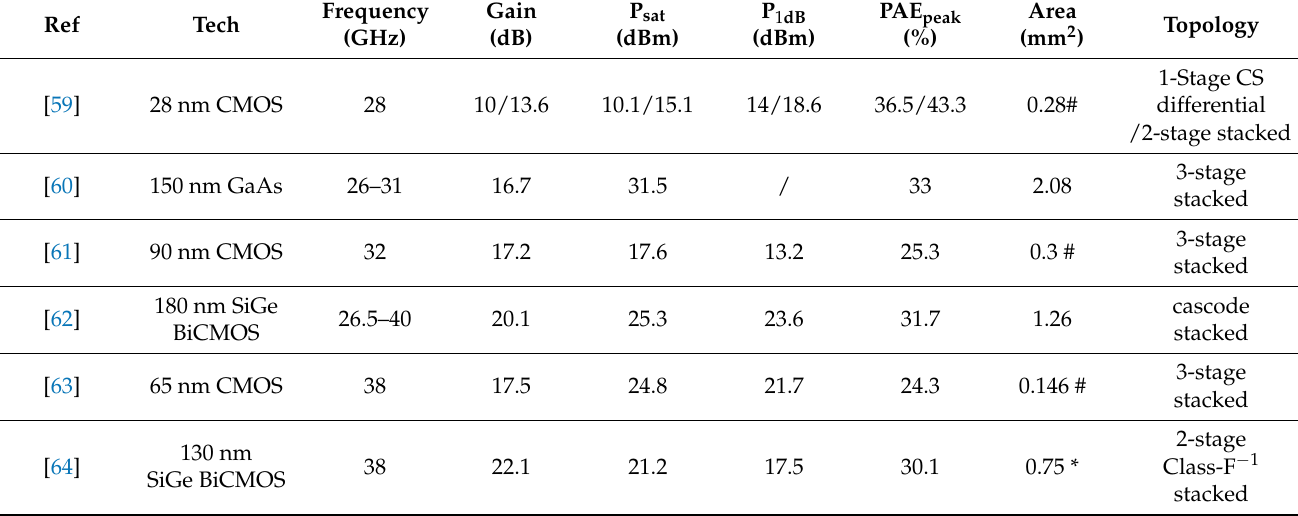
Table 3. Comparison of the measurement results with the stacked-FET